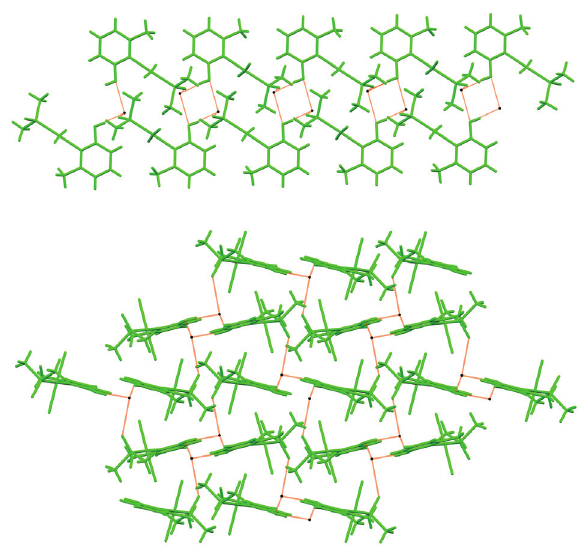
Fig. 4. Section of an infinite layer: a view along b -axis (top) and along a -axis (bottom).